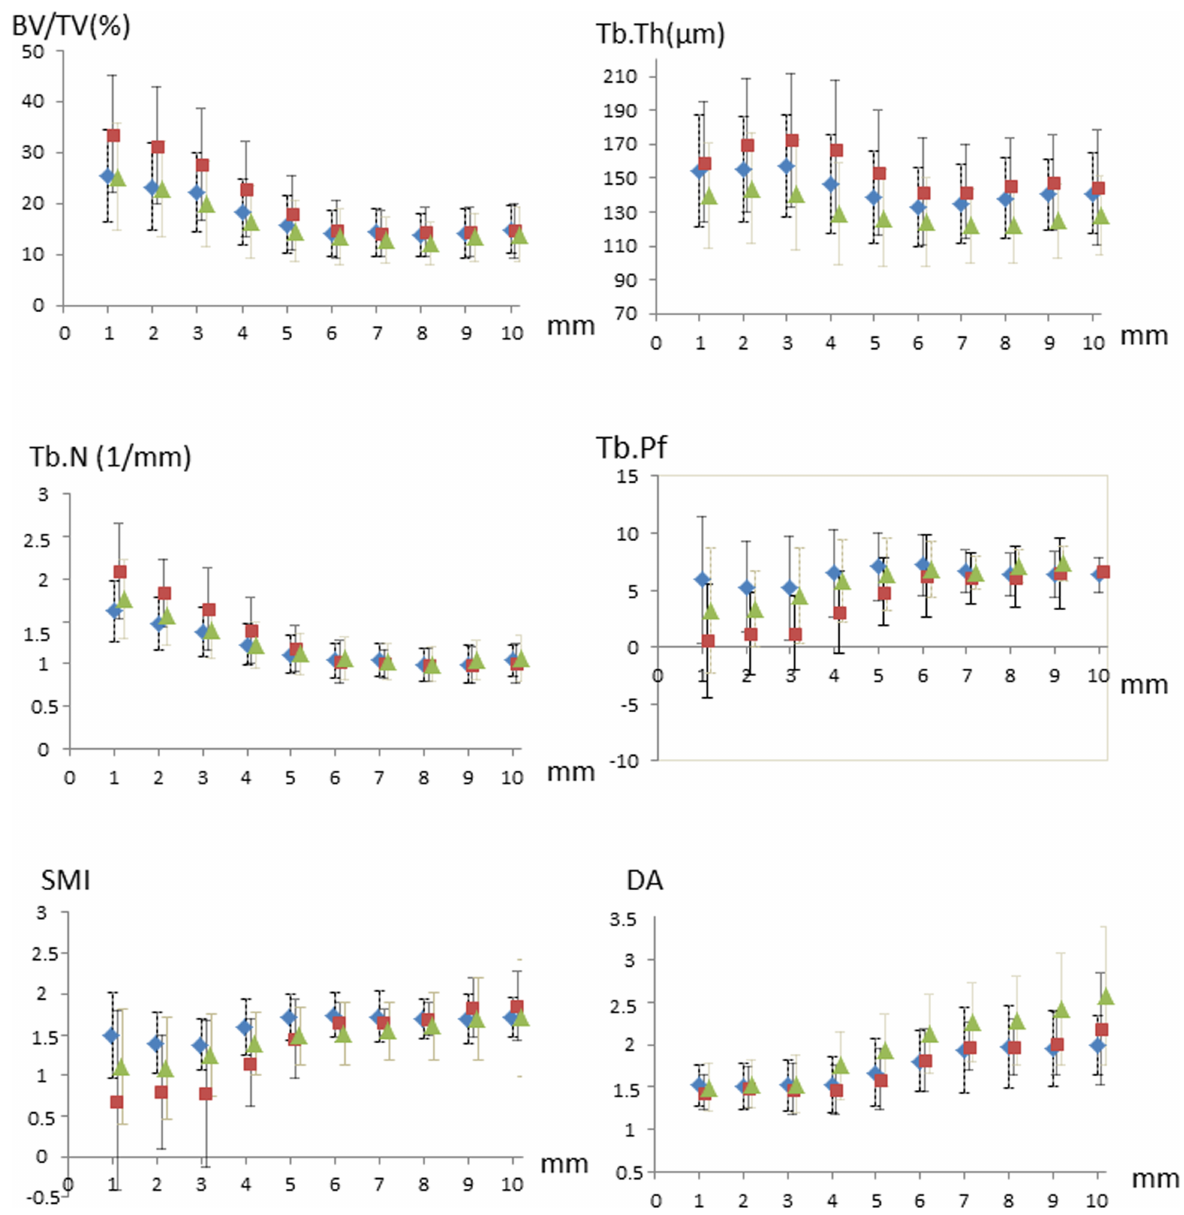
Kruskal-Wallis test otherwise.Data are mean ± SD. BV/TV, bonevolume fraction (mineralizedbonevolume/totalbone volume); Tb.Th, trabecular thickness; Tb.N, trabecular number; Tb.Pf, trabecularpattern factor; SMI, structure model index; DA, degreeof anisotropy, POST, posterior samplingsite (partiallycovered); CENT, central samplingsite (uncovered);PER, peripheralsamplingsite (fully